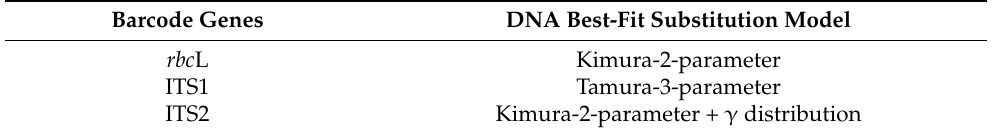
Table 3. DNA best-fit substitution model depicted from MEGAX software for the three DNA barcodes. Barcode